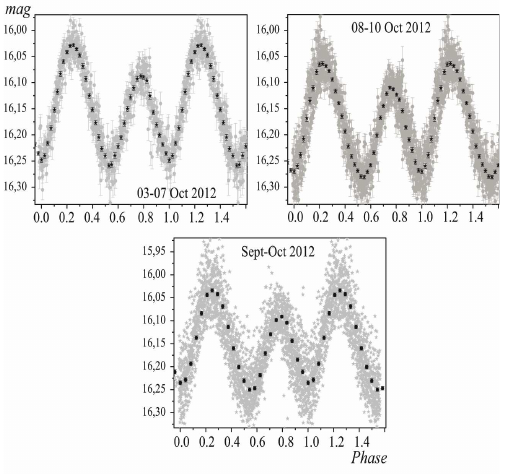
Figure 6: The average LCs in September–October 2012, folded with ephemeris (1). The notation is the same as in Fig.